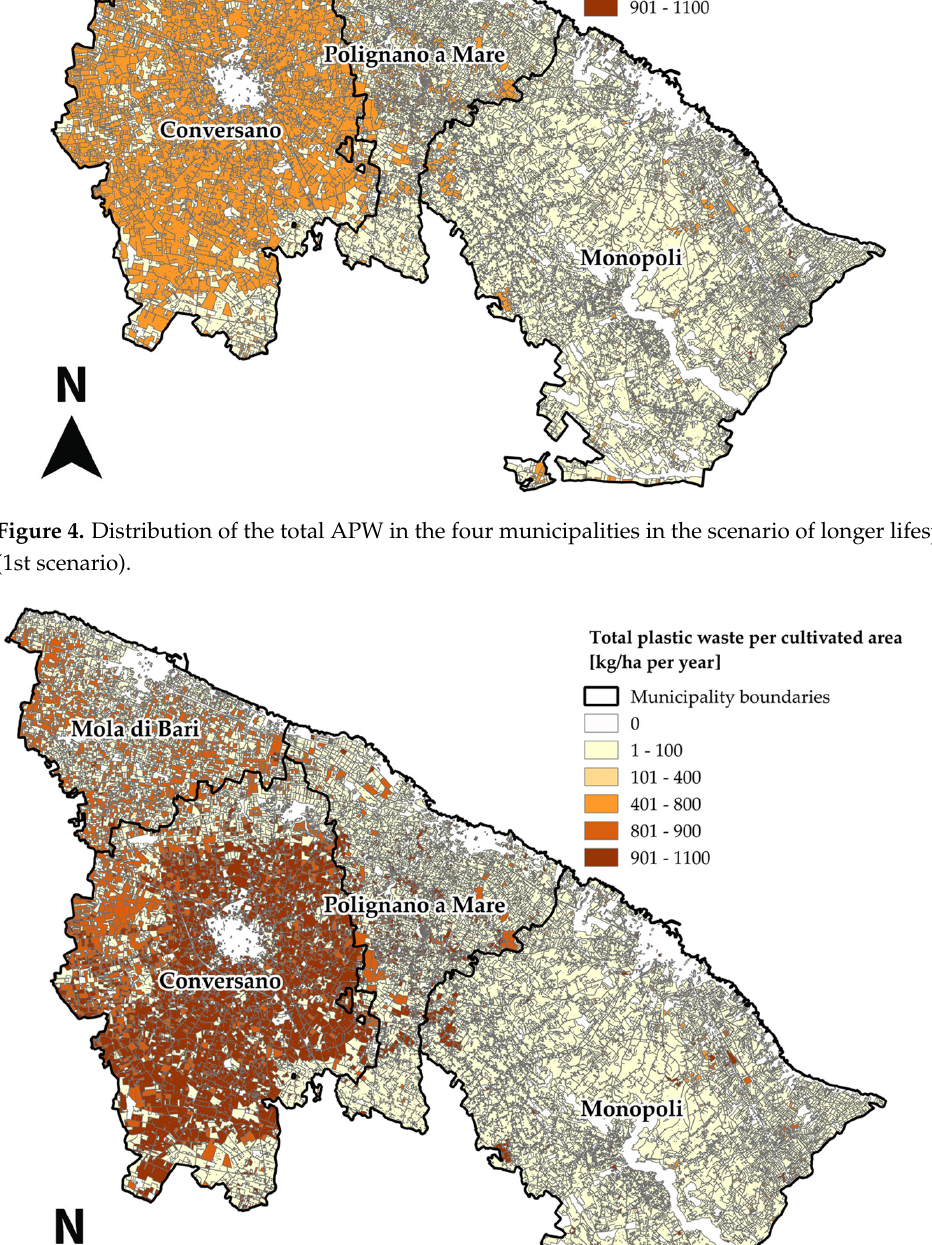
Figure 6. Distribution of the total APW in the four municipalities in the case of combination of the two improved scenarios (scenario comb).